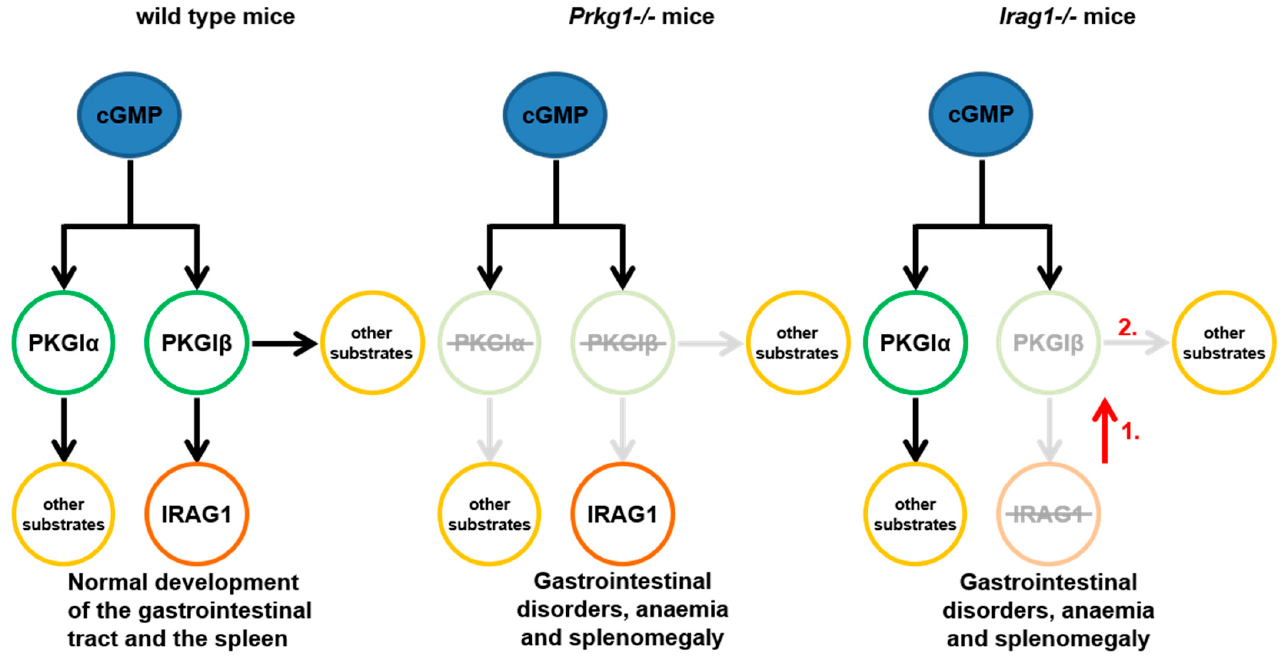
Figure 9. The effect of PKGI β /IRAG1 signaling on pathophysiological functions. Wild-type mice have a normal expression of the PKGI α , PKGI β and IRAG1. Thus, these mice have a normal gastrointestinal function and develop no anemia and splenomegaly. Global Prkg1 -deficient mice ( Prkg1 − / − ) developed all these symptoms [9,12] presumed by the loss of stimulation of their substrate proteins, e.g., IRAG1. Irag1 -deficient mice ( Irag1 − / − ) developed gastrointestinal disorders, anemia and splenomegaly, as well as Prkg1 -deficient mice. Indeed, the loss of IRAG1 causes a reduction of PKGI β protein (1) with the consequence of a reduced stimulation of other substrate proteins of the PKGI β (2), while protein expression of PKGI α is not altered to wild type mice. Crossed out enzymes/proteins indicate genetically deleted enzymes/proteins, and light colors symbolize inactive or deficient signaling pathways.